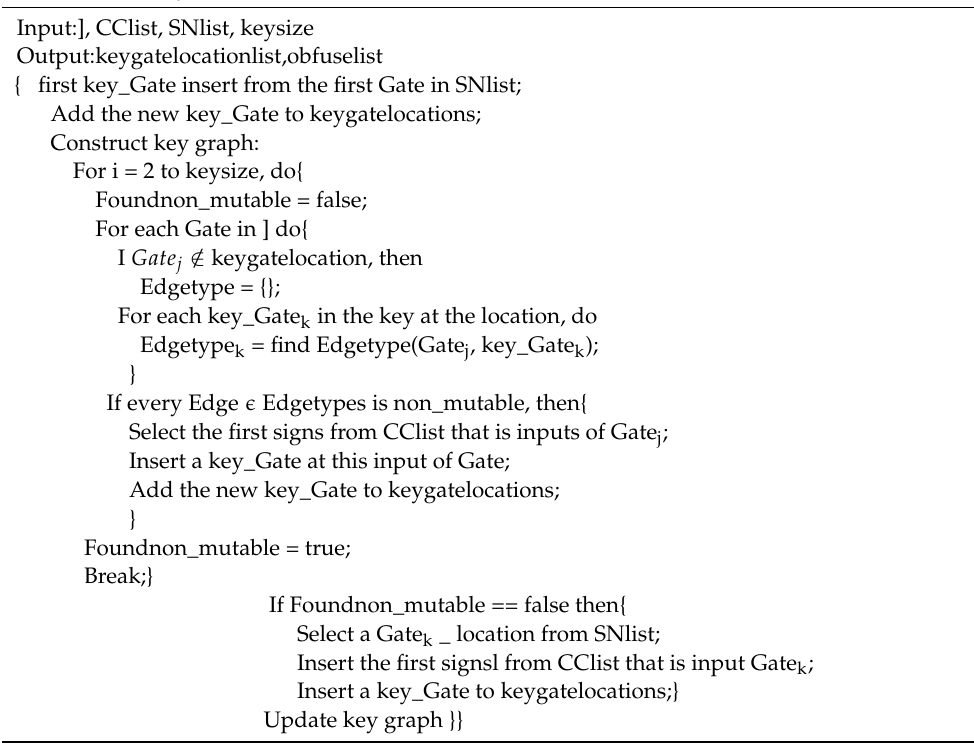
Algorithm 3: key_Gate